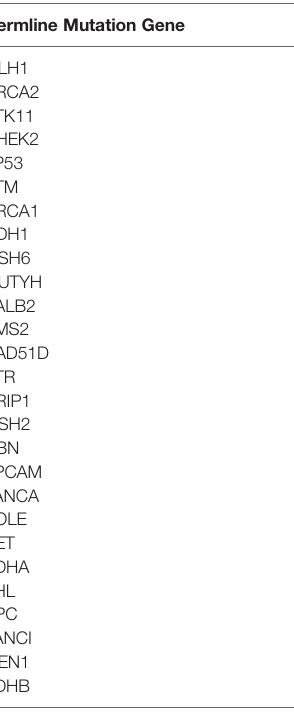
TABLE 4 | Common germline gene mutations of 2706 Chinese LUAD